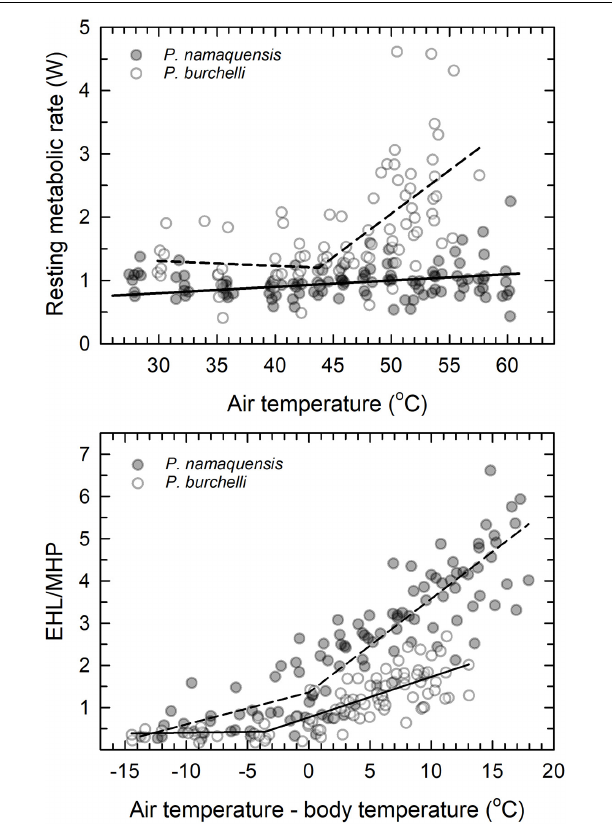
FIGURE 5 | Comparison of relationships between resting metabolic rate (RMR) and air temperature ( T air ) (upper panel) and ratio of evaporative heat loss (EHL) to metabolic heat production (MHP) and gradient between air temperature ( T air ) and body temperature ( T b ) (lower panel) in two congeneric southern African sandgrouse, Namaqua ( Pterocles namaqua , this study) and Burchell’s ( Pterocles burchelli , McKechnie et al., 2016b). Note the clear upper critical limit thermoneutrality ( T uc ) above which RMR increases rapidly in P . burchelli , compared to the lack of a T uc and RMR that remains within in ∼ 37% of minimum values in P. namaqua . The relationship between RMR and T air in P. namaqua was non-significant. Despite the larger evaporative scope (maximum EWL/minimum EWL) of P. burchelli (11.0, McKechnie et al., 2016b) compared to P. namaqua (7.4, this study), the latter species achieves much higher EHL/MHP and tolerates T air values ∼ 4 ◦ C higher compared with the former (lower panel).